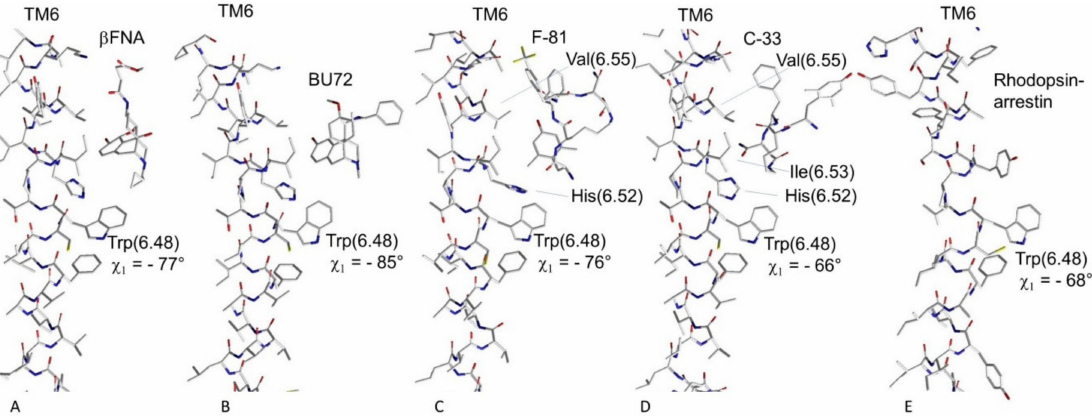
Figure 8. Side views of TM6 as extracted from the complexes of MOP with ( A ) the antagonist β FNA [59], ( B ) the G- protein biased agonists BU72 [61] and ( C ) F-81, ( D ) the β -arrestin biased agonist C-33, and ( E ) from the rhodopsin–arrestin complex